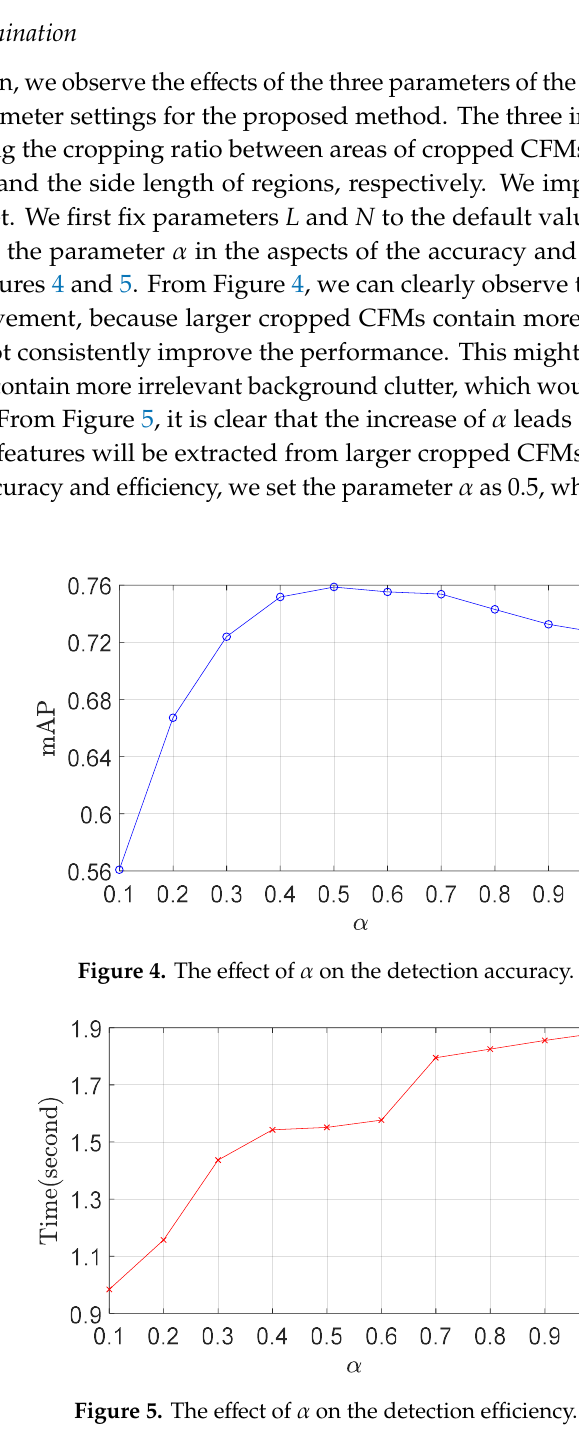
Figure 6. The effect of N on the detection accuracy. Figure 7. The effect of N on the detection efficiency. The effects of L are illustrated in Figures 8 and 9. It is clear that the detection performance degrades if L is too large or too small. That is because a smaller L results in smaller local regions,